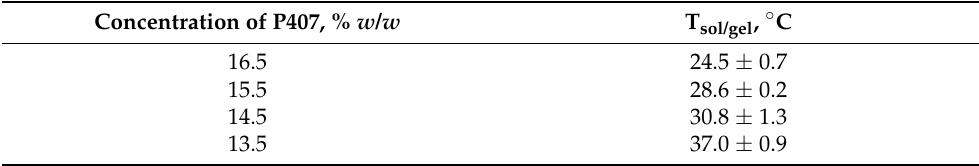
Table 1. Increasing T sol/gel with decreasing concentrations of